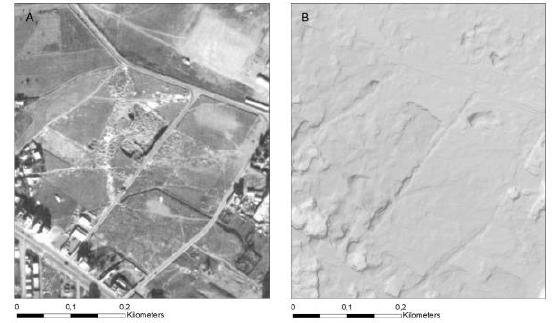
Figure 17. A) ortho-rectified photogram, B) DEM of the same zone, visualized in hill-shaded stretched